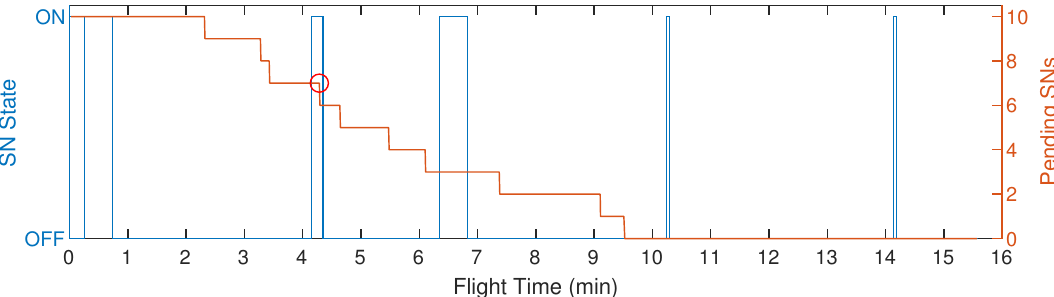
Figure 21. Graphical representation of an SN active and hibernation states, considering S 1 with 10